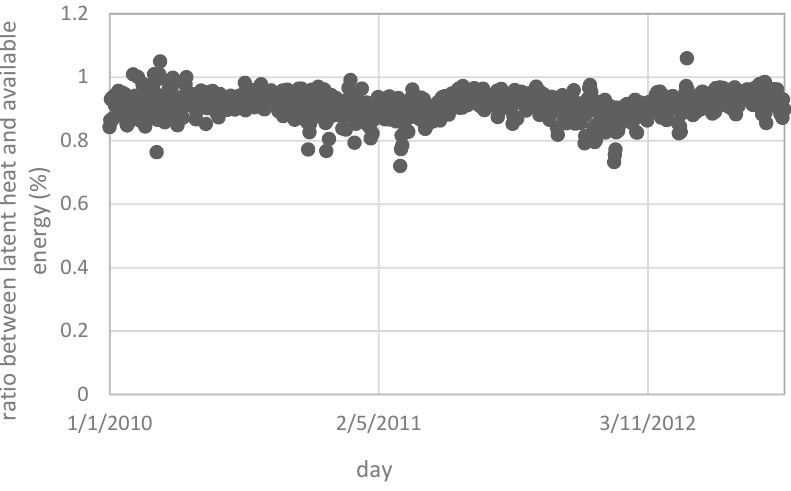
Figure 3. Evaporative fraction over the Atlantic Ocean in the period of (January 2010–September 2012).